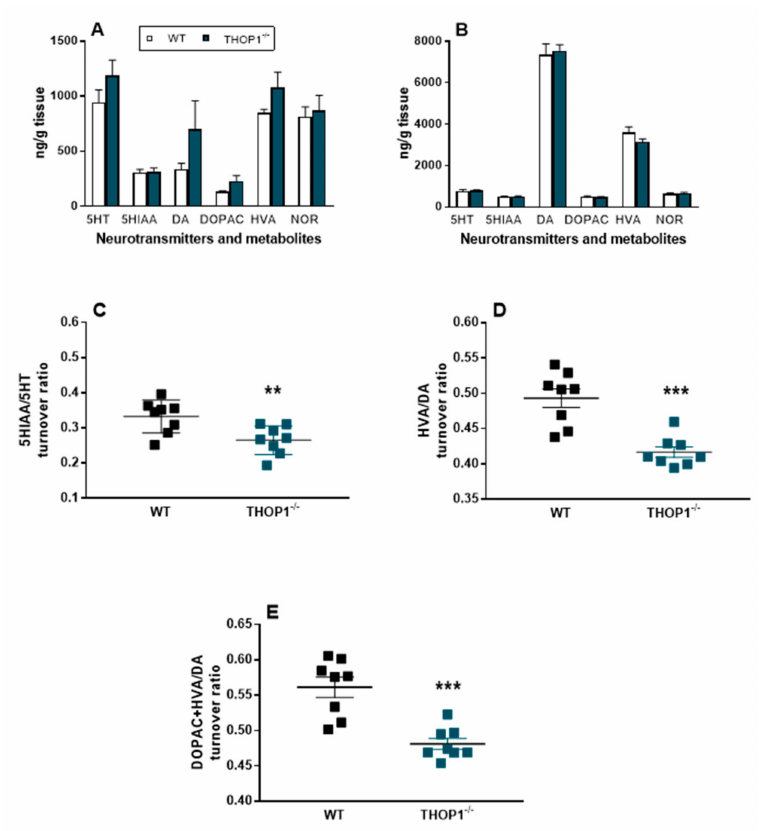
Figure 9. Neurotransmitters and their metabolites levels in two di ff erent brain regions of WT and THOP1 - / - mice. No di ff erences were observed among the neurotransmitters and their metabolites in the PFC ( A ) or ST ( B ) from WT mice compared to THOP1 - / - mice. However, the turnover ratio of 5HIAA / 5HT was significantly lower in PFC of THOP1 - / - mice ( C ). Similarly, the turnover ratios of HVA / DA ( D ) and DOPAC + HVA / DA ( E ) are lower in ST of THOP1 - / - mice compared to WT mice. Results are expressed as mean ± S.E.M. Statistical significance was determined by Student’s t -test: ** p < 0.01; *** p < 0.001 vs. WT. n =